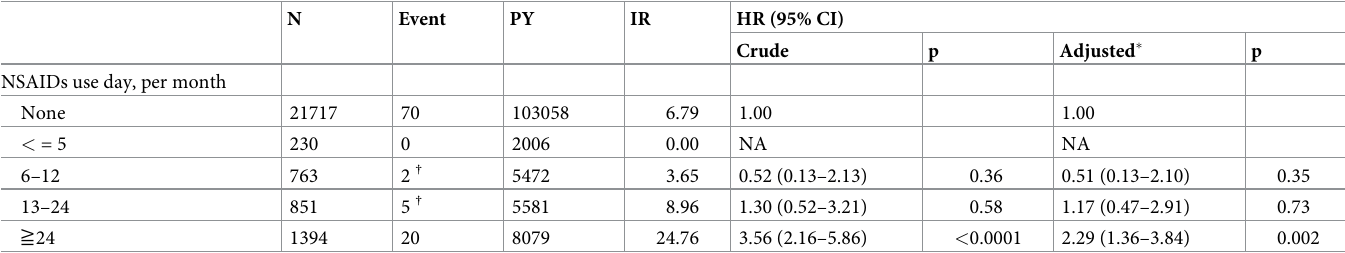
Model was adjusted for age, pregnancy and all comorbidities listed in Table 1. † event: less than